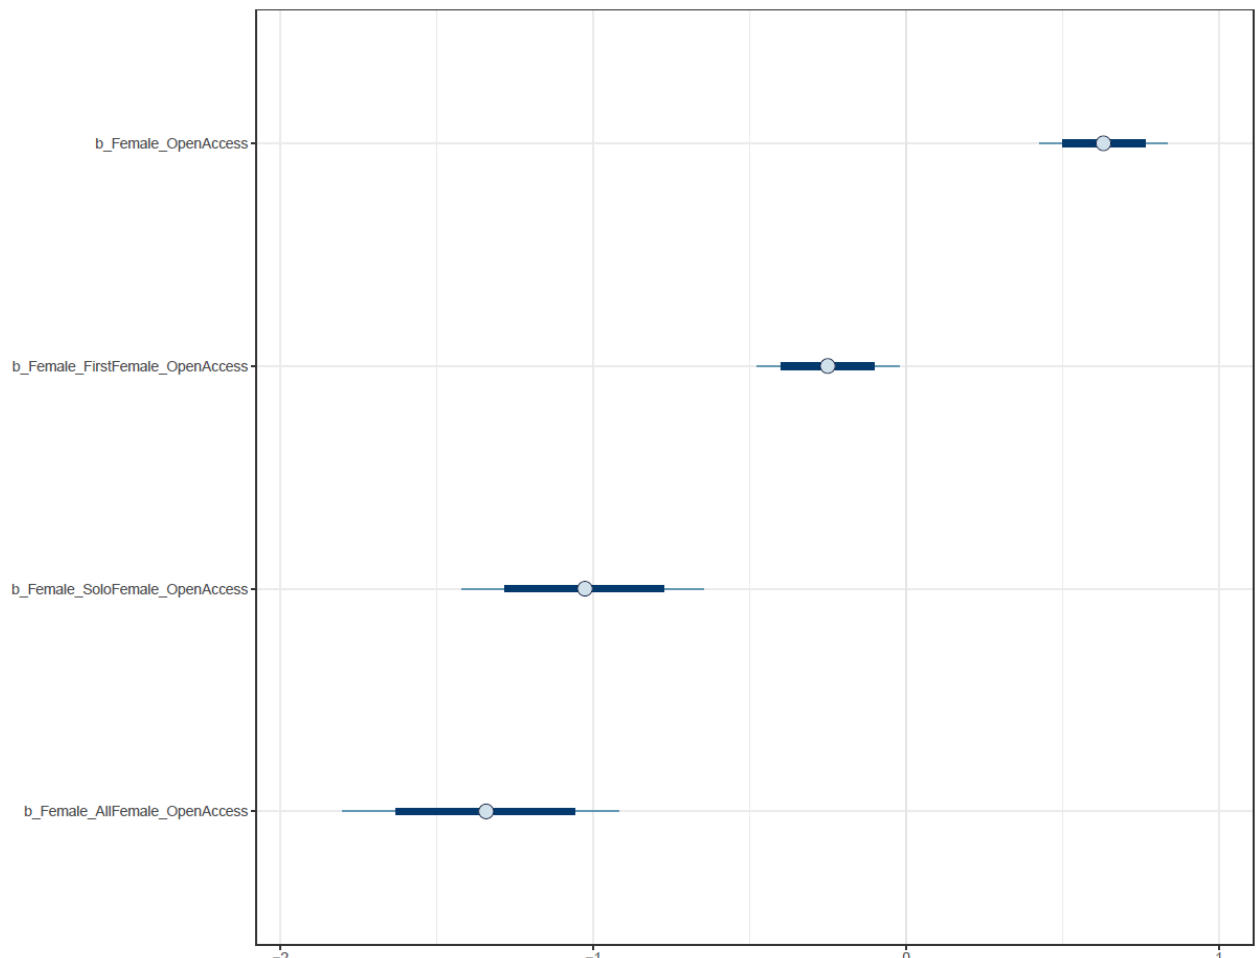
Figure 7. Interval plot demonstrating the probability distribution of coefficients. The following logit model can calculate the probability of publishing under each authorship structure’s Gold Access status. As Bayesian analysis treats all parameters probabilistically, we selected the mean value of the distribution because it had the highest probability of happening (see Equation